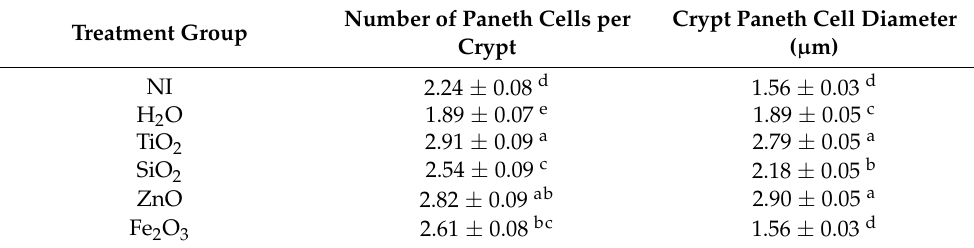
Table 8. Effects of intraamniotic administration of experimental food-grade NP solutions on Paneth cells per crypt and Paneth cells diameter 1